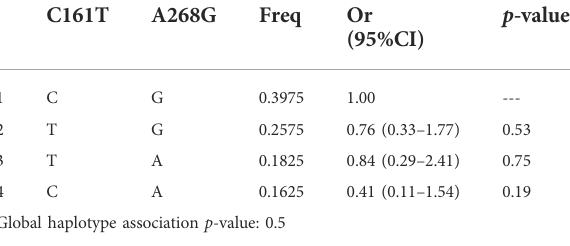
TABLE 5 Haplotype association of UGT2B7 C161T and A268G with response (n = 100, adjusted by Age + Sex).